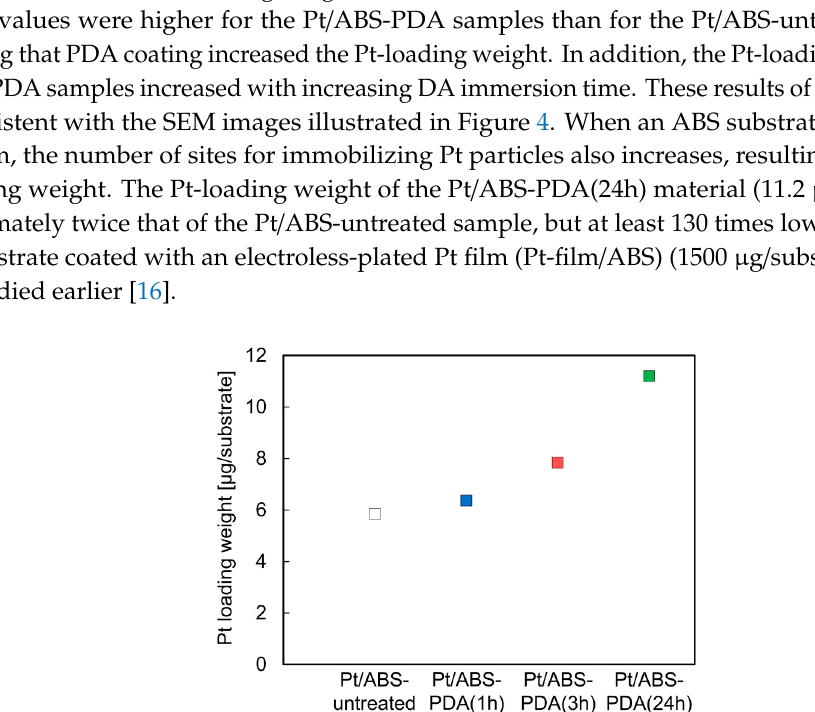
Figure 4. Scanning electron microscope (SEM) images of the surface of an ABS substrate before and after PDA coating and Pt immobilization: ( a ) Pt/ABS-untreated, ( b ) Pt/ABS-PDA(1h), ( c ) Pt/ABS- PDA(3h), and ( d ) Pt/ABS-PDA(24h).